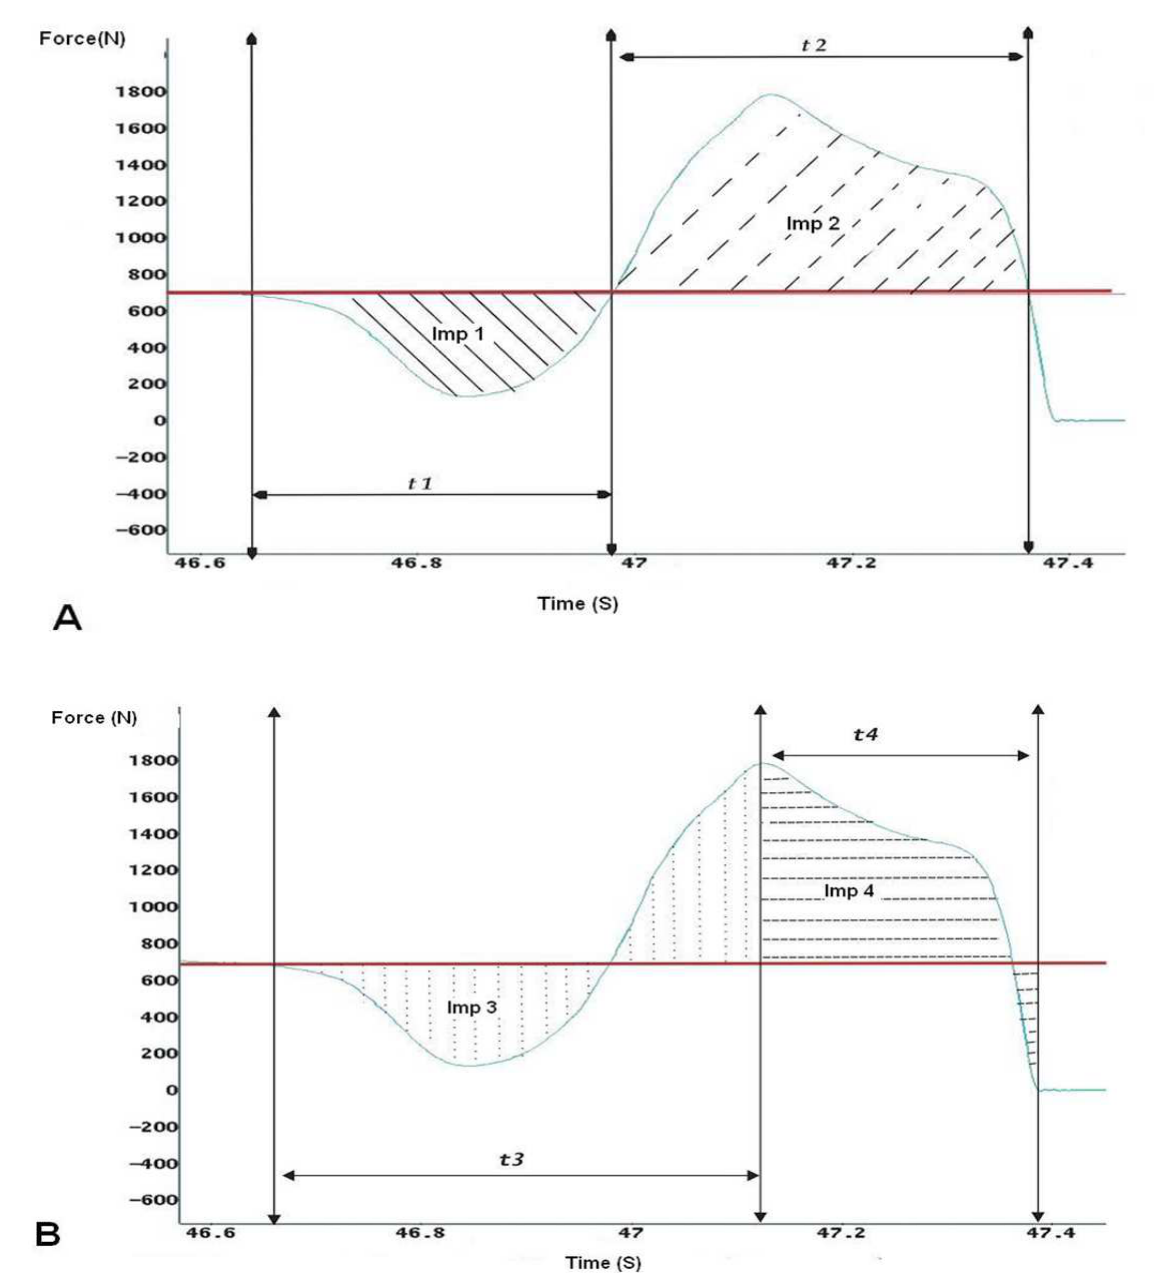
Figure 2. A) The curve is divided by the relation between Fy and P. B) the curve is divided in function of the positive or negative external mechanic working times. The nomenclature for the times and impulses are explained in the